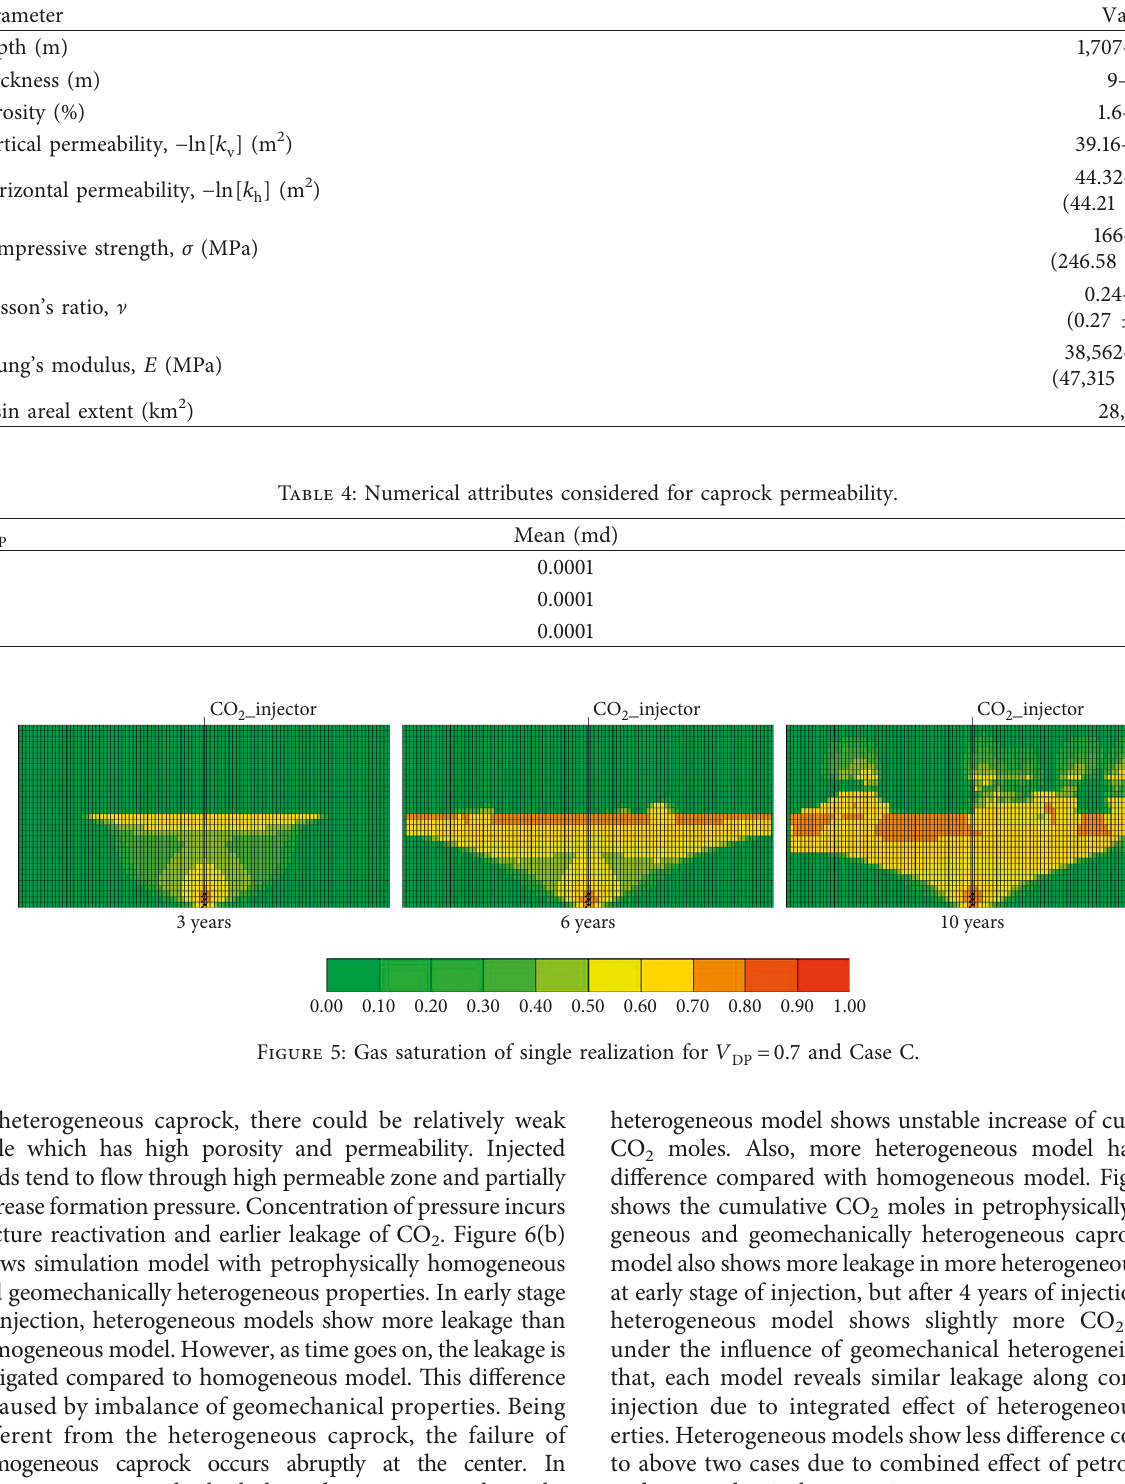
2 sequestration in the Paradox